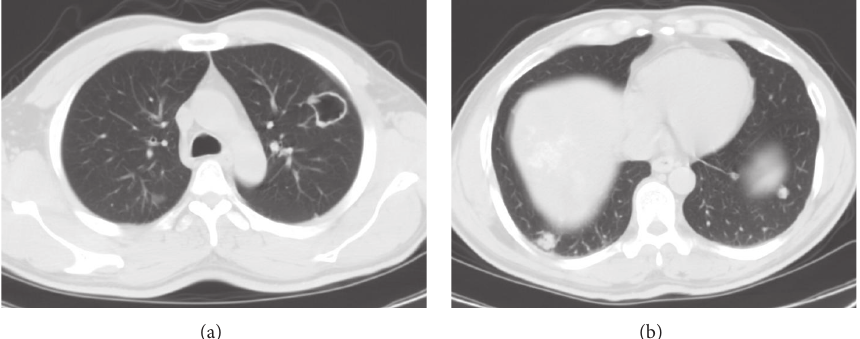
Figure 2: Thorax CT reveals multiple noncalcified nodular lesions in both lungs (a). A cavitary lesion with thick irregular wall is seen in the upper lobe of the left lung